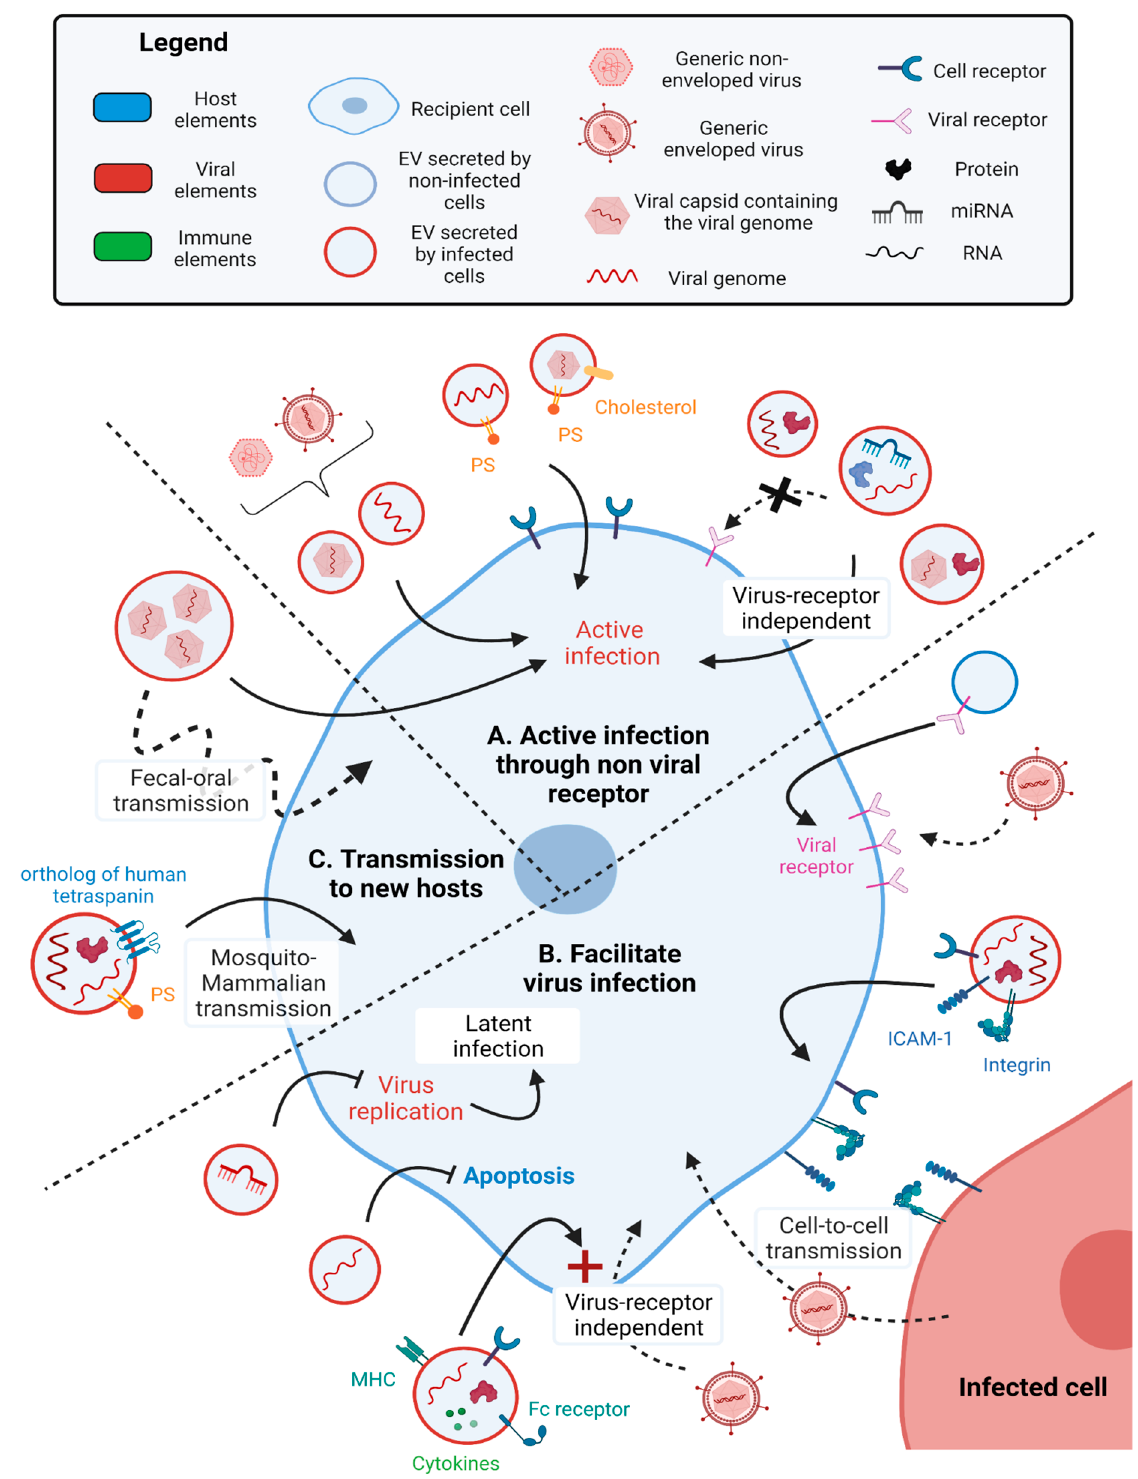
Figure 2. Virus-EVs increase viral uptake by recipient cells. ( A ) Virus-EVs increase viral uptake and active infection by recipient cells. Both enveloped [HCMV, HHV-6, Sars-CoV-2, DV, HBV] and non-enveloped [HAV, HEV, EV71, Bluetongue virus] viruses are secreted inside virus-EVs and induce active infection of recipient cells. The transport of the viral genome inside virus-EVs can also induce active infection of recipient cells [Pegivirus] [56]. Moreover, virus-EVs can present PS at their surface, which enhances their uptake into recipient cells [HAV [59], EBV [61,62], Zika virus [57], HIV [58], Cox- sackievirus B3, rhinovirus, poliovirus [60]. Virus-EVs also induce active infection of recipient cells in a receptor-independent fashion, as observed with virus-EVs containing the viral genome and proteins,